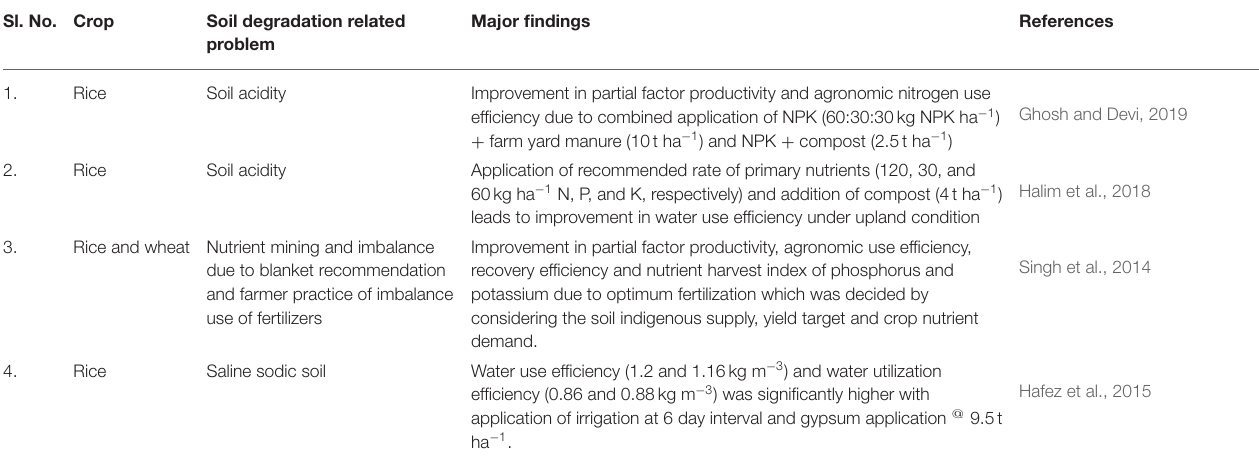
TABLE 9 | Effects of soil degradation on nutrient and water use efficiency. Sl. No.